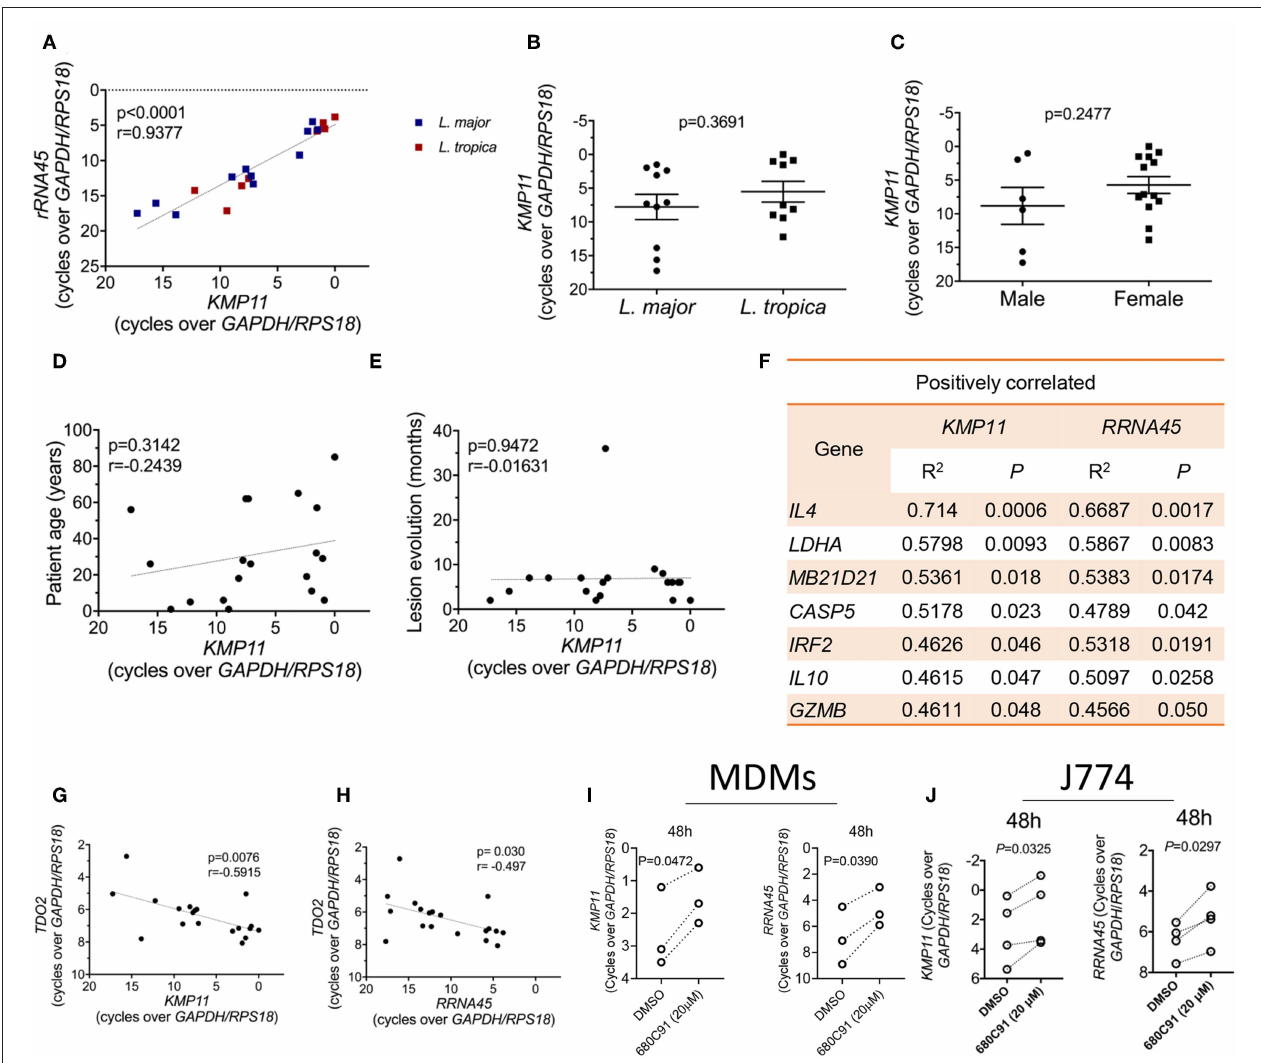
FIGURE 4 | TDO gene expression is inversely correlated with the parasite load in lesions and inhibition of TDO boosts the parasite load in L. major -infected macrophages. (A) Correlation between the transcript levels of the Leishmania genes KMP11 and RRNA45 in CL biopsies from patients infected with L. major or L. tropica (Pearson correlation coefficient). (B) Comparison of the level of KMP11 expression between L. major and L. tropica biopsies (unpaired T -test). (C) Comparison of the level of KMP11 expression between biopsies from male and female patients (unpaired T -test). (D) Correlation between the level of KMP11 expression and the age of CL patients (Pearson correlation coefficient). (E) Correlation between the level of expression of KMP11 and the time in months after lesion appearance (Pearson correlation coefficient). (F) Table of genes whose expression is significantly ( P < 0.05) positively correlated with the expression levels of both KMP11 and RRNA45 . (G) Correlation between the levels of mRNA expression of KMP11 and TDO2 (Pearson correlation coefficient). (H) (Correlation between the levels of mRNA expression of RRNA45 and TDO2 (Pearson correlation coefficient). (I,J) MDMs (I) or J774 cells (J) were infected with L. major stationary phase promastigotes and subsequently treated with 20 µ M of the TDO specific inhibitor, 680C91 or vehicle (DMSO). Cells were lysed for RNA extraction at 48h after infection. The transcript levels of the Leishmania genes KMP11 (left panels) or RRNA45 (right panels) were quantified by qPCR and normalized by the expression of the host housekeeping genes ( GAPDH and RPS18 ) (paired T -test). (A–E,G,H) Each dot represents an individual CL skin biopsy. (I) Each paired dot represents an independent blood donor ( n = 3). (J) Each paired dot represents an independent experiment ( n =